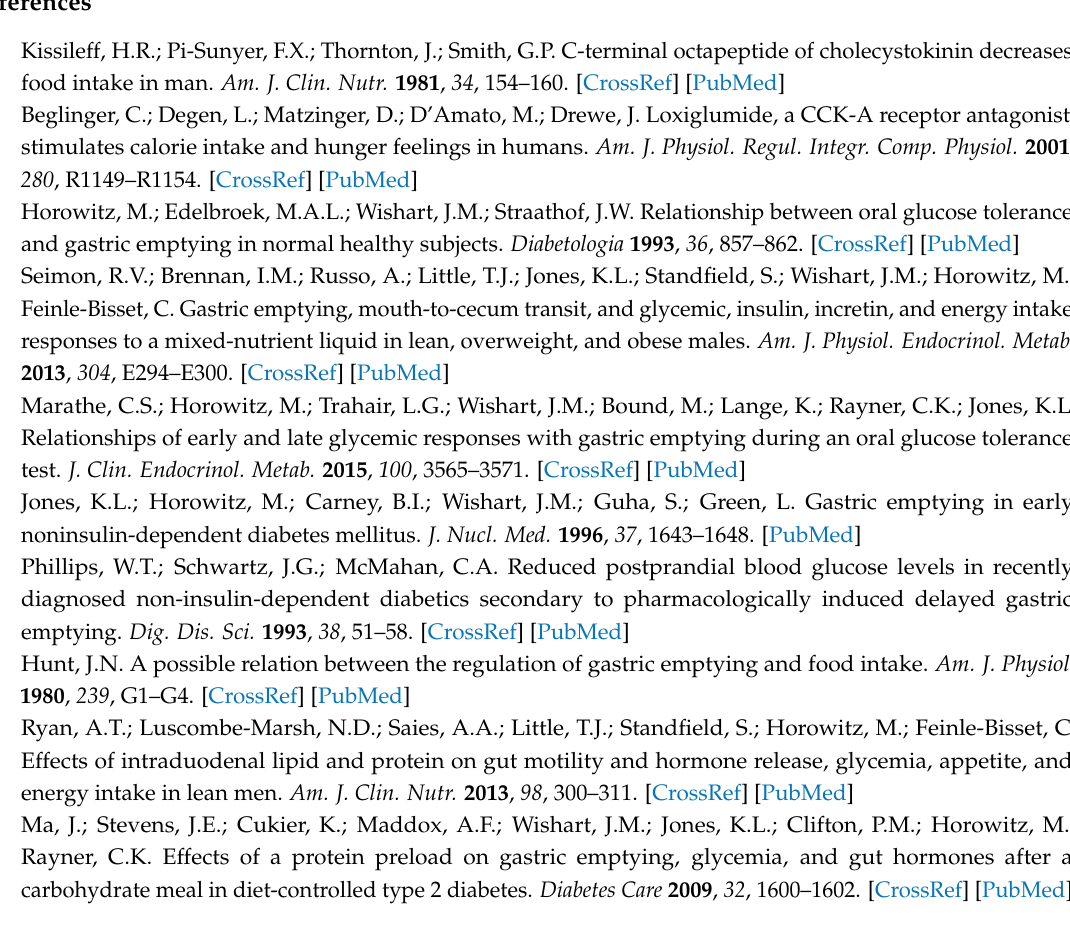
Figure S1: Hunger (A,E), desire to eat (B,F), prospective consumption (C,G) and fullness (D,H) at baseline ( t = − 20 min) and in response to an oral mixed-nutrient drink ( t = 0 min) following intragastric infusion of tryptophan, at doses of 1.5 g (‘Trp-1.5g’) or 3.0 g (‘Trp-3.0g’), or control, in healthy normalweight (A–D) and obese (E–H) volunteers. Data are means ± SEM, n = 16, Figure S2: Nausea (A,C) and bloating (B,D) at baseline ( t = − 20 min) and in response to an oral mixed-nutrient drink ( t = 0 min) following intragastric infusion of tryptophan, at doses of 1.5 g (‘Trp-1.5g’) or 3.0 g (‘Trp-3.0g’), or control, in healthy normal-weight (A,B) and obese (C,D) volunteers. Data are means ± SEM, n =